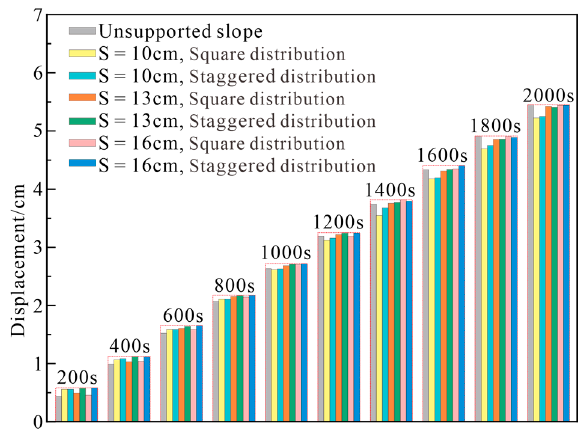
Figure 12. Effect of plant spacing and planting pattern of tap-like root system on slope surface displacement with constant root volume.